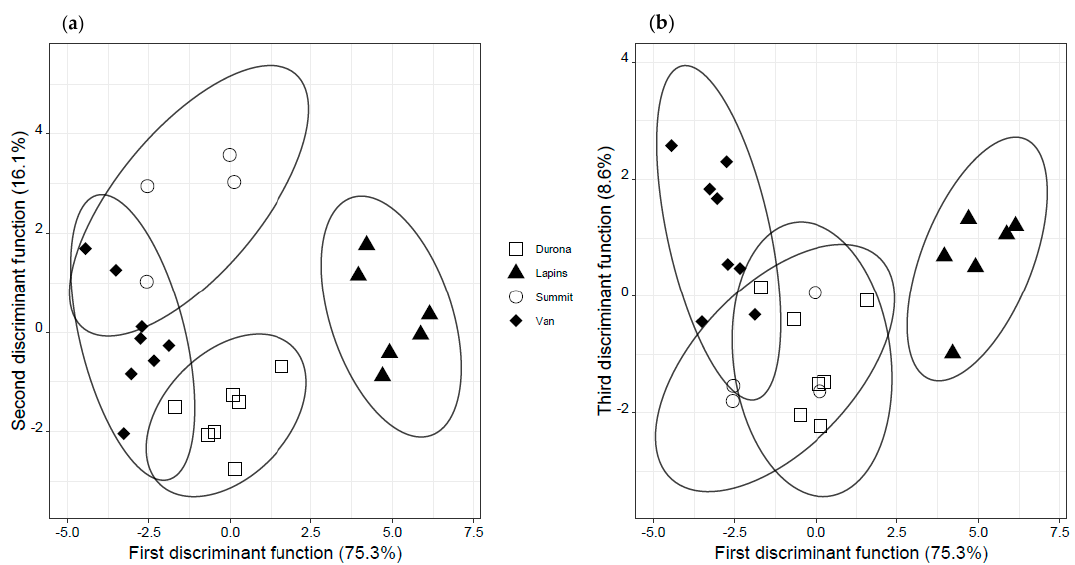
Figure 3. Discrimination of sweet cherries according to four cultivars ( (cid:3) Durona; (cid:78) Lapins; ◦ Summit; or, (cid:7) Van) using a LDA-SA model based on nine selected biometric-physicochemical characteristics (L* and a* CIELAB color scales, titratable acidity, penetration force, length, maximum and minimum diameter, stone weight, and pulp / stone mass ratio): ( a ) 2D-plot of the first and second discriminant functions; ( b ) 2D-plot of the first and third discriminant functions. The full ellipses represent the confidence region boundaries determined based on the posterior probabilities calculated for each class membership.